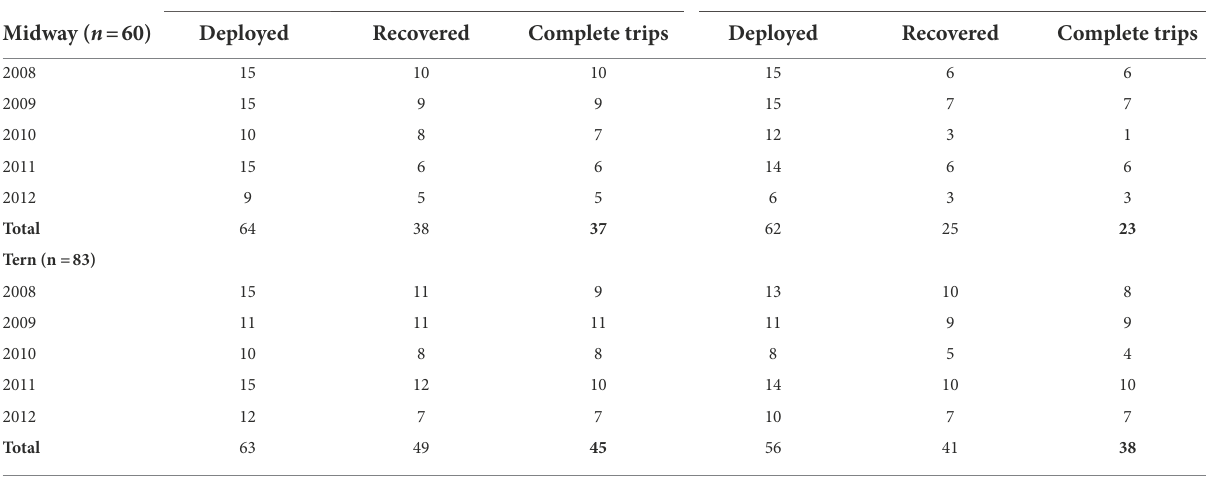
Bold values indicate number of tracks used for analysis by